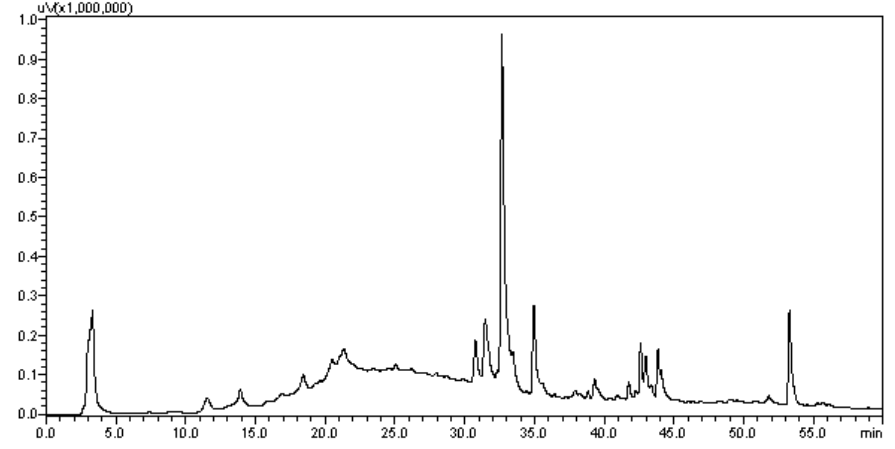
Figure 2. Chromatogram of the hydroalcoholic extracts of Vismia guianensis obtained by HPLC with UV detection (HPLC–PDA) for the hydromodule 1:10 with defined peaks and areas.